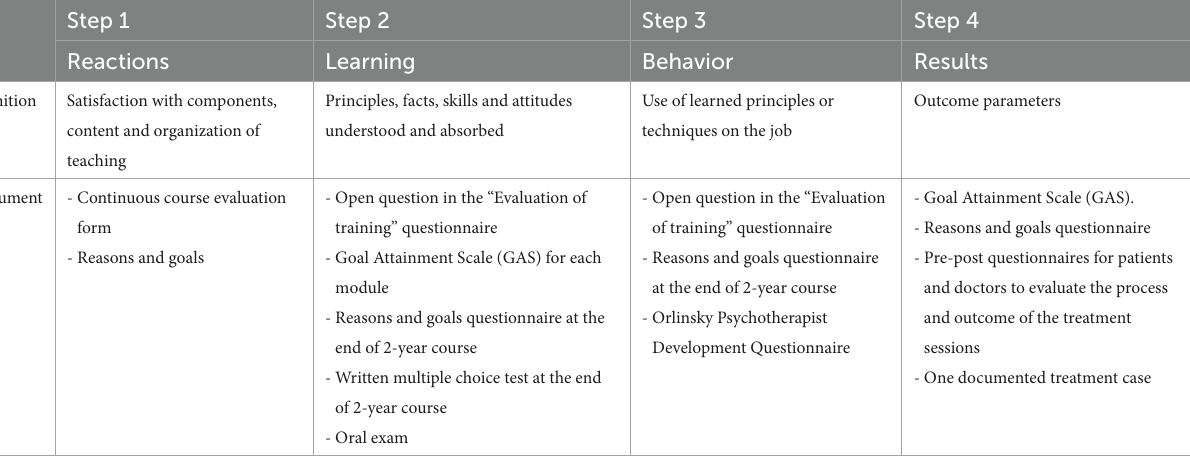
TABLE 2 Evaluation